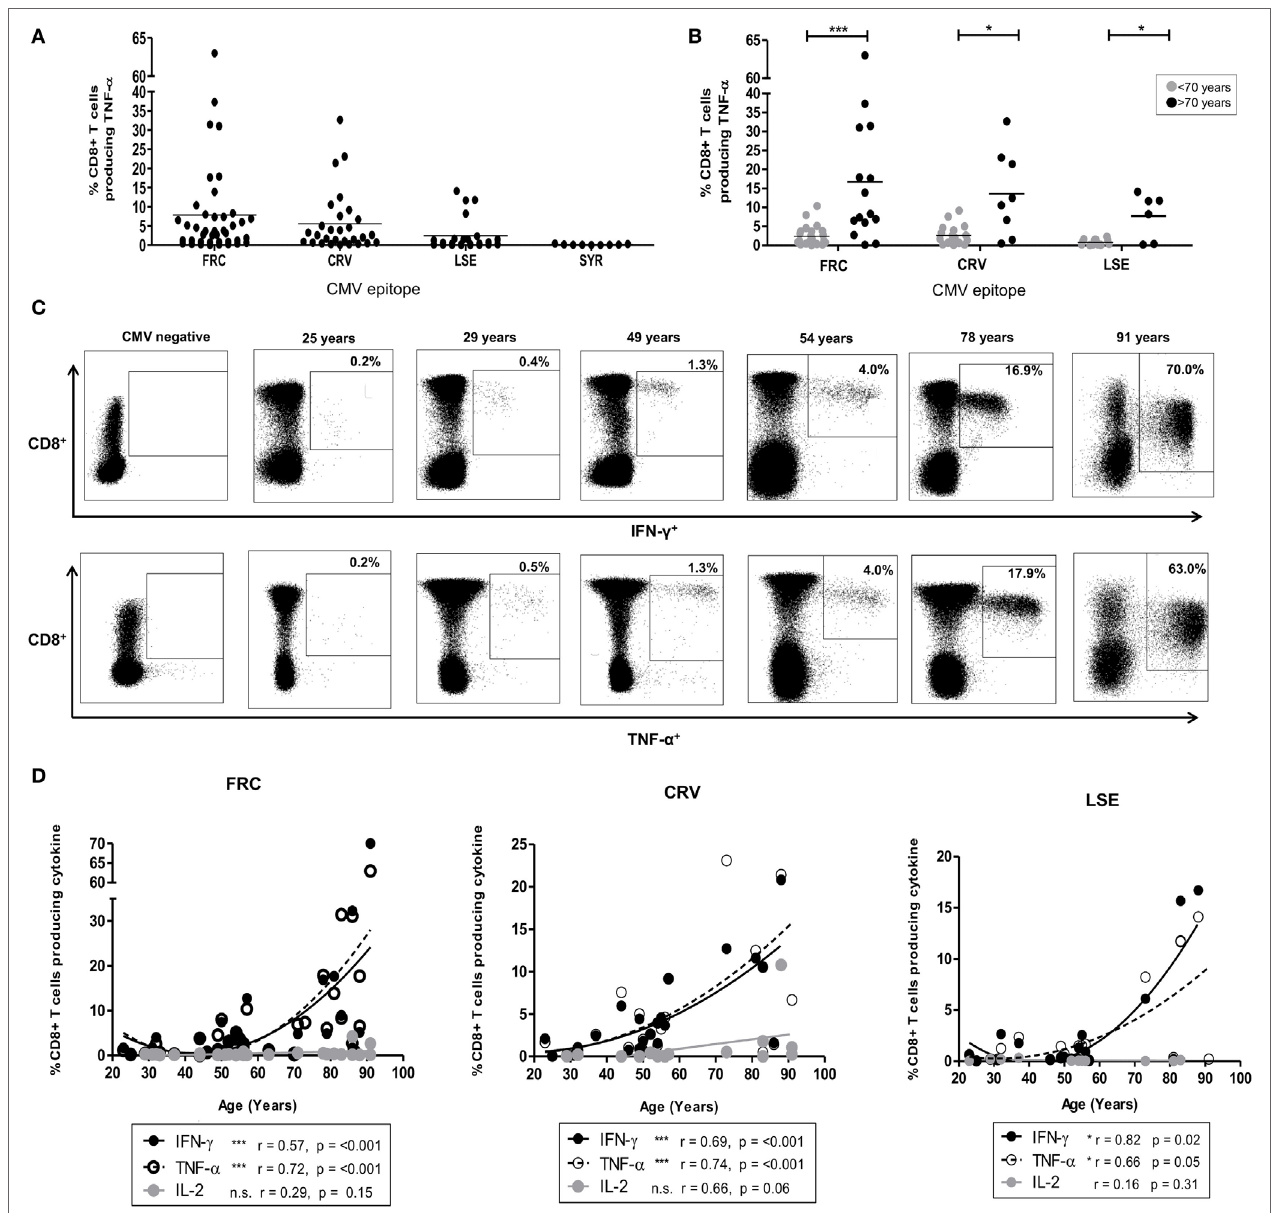
FigUre 1 | CD8 + T-cell response after stimulation by cytomegalovirus (CMV) peptides restricted by HLA-Cw*0702. (a) The magnitude of CD8 + T-cell TNF- α production in response to peptide stimulation in HLA-Cw*0702 + CMV-seropositive donors. Peptide-specific CD8 + T-cells were identified after peptide stimulation and intracellular cytokine staining. Each symbol represents the percentage of an individual donor’s total CD8 + T-cell pool producing TNF- α in response to the peptide. The peptide name and temporal pattern of expression during the viral lifecycle are shown on the x -axis. Horizontal lines represent the mean. (b) The magnitude of CD8 + T-cell TNF- α production in response to peptide stimulation in HLA-Cw*070 2 + CMV-seropositive donors aged < 70 or > 70 years of age. Peptide-specific CD8 + T-cells were identified as in panel (a) . Each symbol represents the percentage of an individual donor’s total CD8 + T-cell pool producing TNF- α in response to the peptide. Gray circles represent donors < 70 years of age, and black circles represent donors > 70 years of age. Horizontal lines represent the mean. Statistical significance was determined by Mann–Whitney within GraphPad Prism 6 (* p < 0.05 and *** p < 0.001). (c) Representative plots of CD8 + T-cell cytokine production in six donors following stimulation with FRC peptide. FRC - specific CD8 + T-cells were identified as in panel (a) to assess IFN- γ (top row) and TNF- α (bottom row) production. CD8 expression is shown on the y -axis and cytokine expression on the x -axis. The age of the donor is provided above the representative plots. The gating strategy is provided in Figure S2 in Supplementary Material. (D) Magnitude of cytokine production following stimulation with peptides FRC, CRV, and LSE shown in donors according to age. Peptide-specific CD8 + T-cells were identified as in panel (a) . The age of the donors in years is shown on the x -axis, and the percentage of the total CD8 + T-cell cytokine response is provided on the y -axis. Significance was calculated by Spearman’s rank